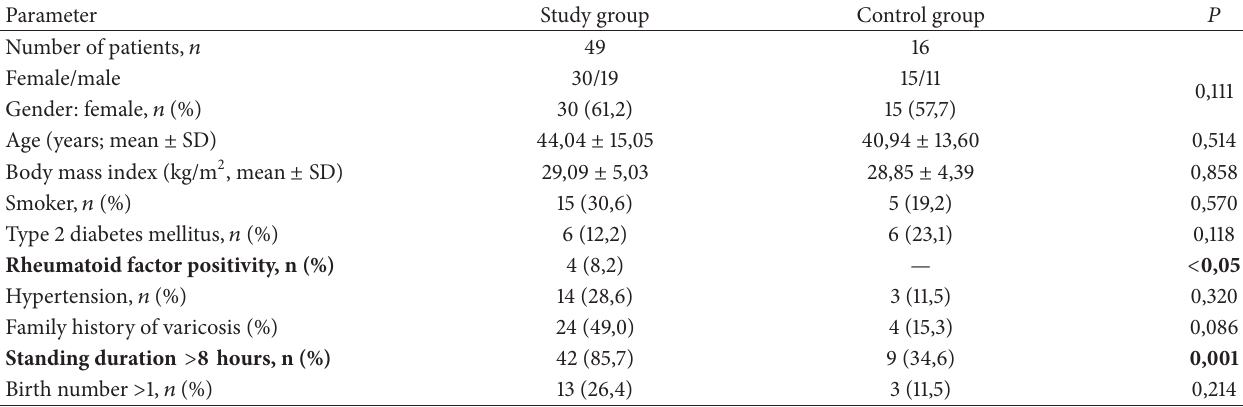
Table 1: Demographic and clinical data of patients.